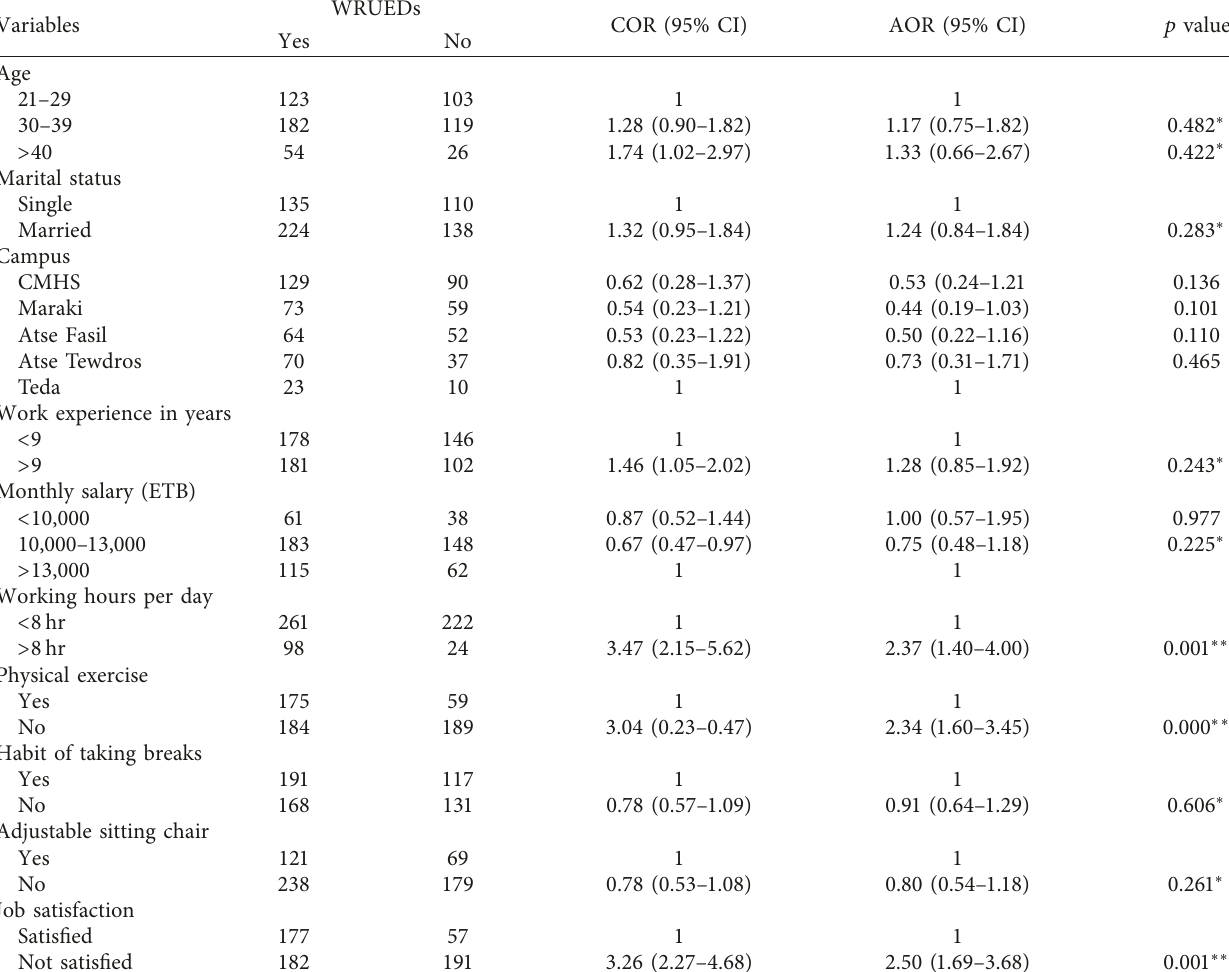
Table 4: Predictors of work-related upper extremity disorders among teaching staff in the University of Gondar, Ethiopia, 2021 ( N � 607).